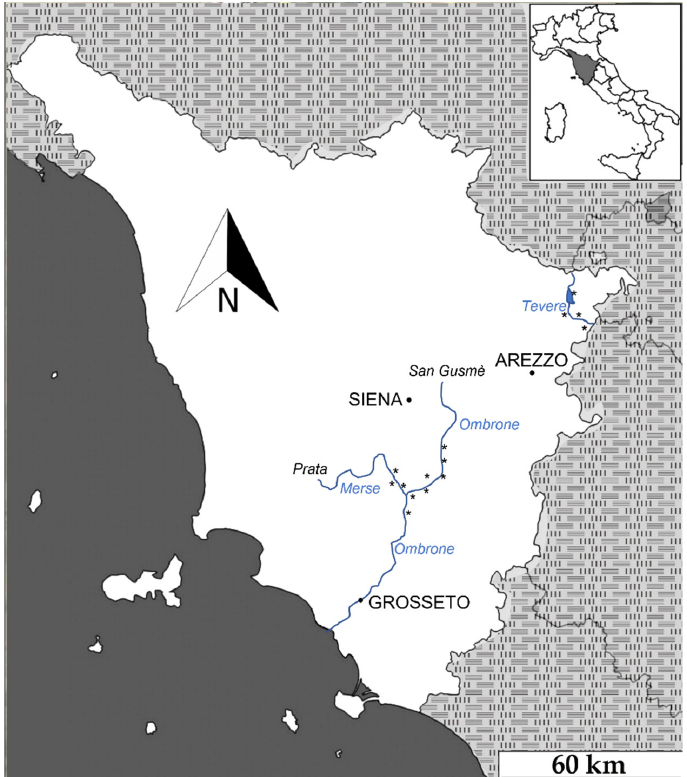
Figure 1. Position of camera trap stations in Tuscany (Central Italy). Asterisks represent camera-trap sites.